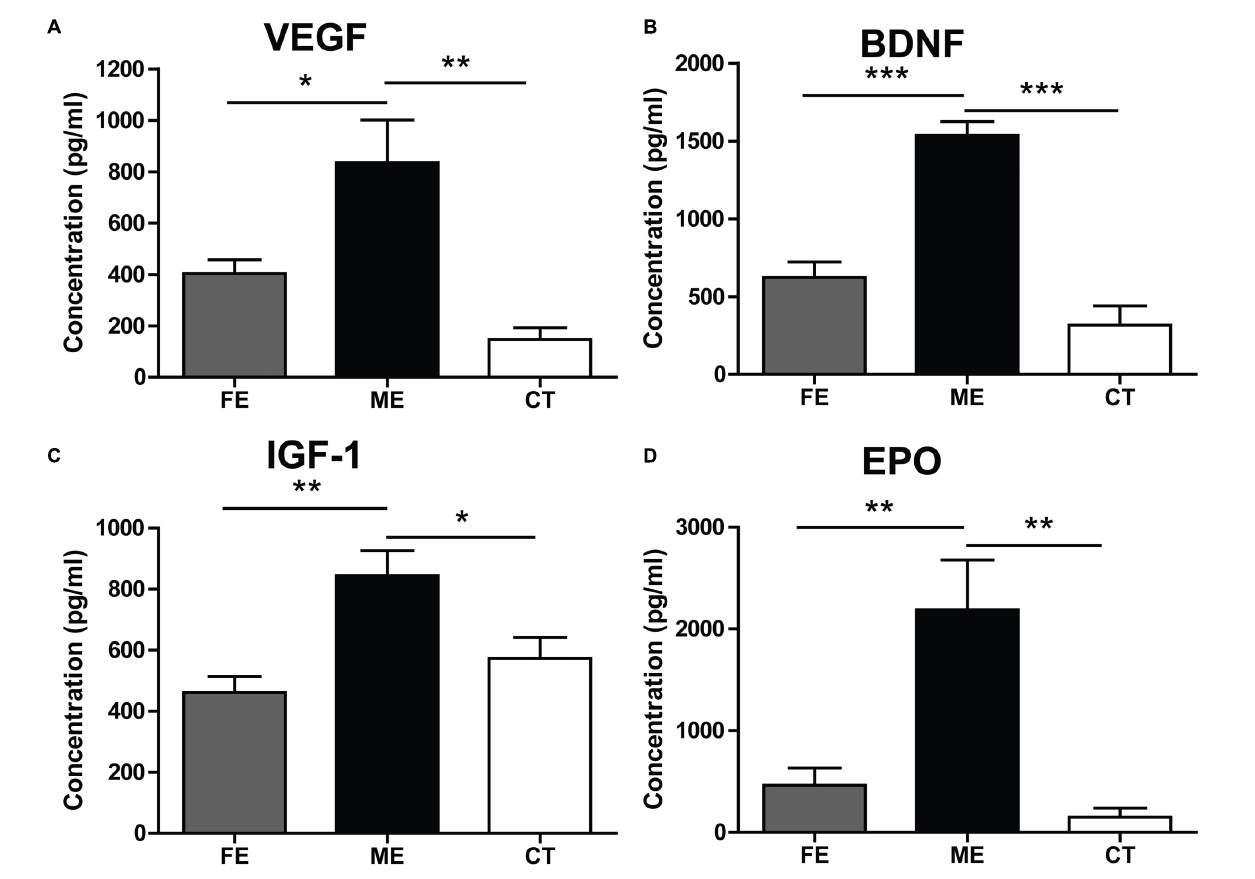
FIGURE 5 | Effects of running on expression of neurotrophic factors vary with intensity. (A) Values of hippocampal VEGF levels. One-way ANOVA, F 2 , 12 = 11.12, P = 0.0019; post hoc test: ME vs. CT: ∗∗ P < 0.01; ME vs. FE: ∗ P < 0.05; FE vs. CT: P > 0.05; n = 5 in each group. (B) Values of hippocampal brain-derived neurotrophic factor (BDNF) levels. One-way ANOVA, F 2 , 12 = 36.43, P < 0.0001; post hoc test: ME vs. CT: ∗∗∗ P < 0.001; ME vs. FE: ∗∗∗ P < 0.001; FE vs. CT: P > 0.05; n = 5 in each group. (C) Values of IGF-1 levels in the brain. One-way ANOVA, F 2 , 12 = 8.315, P = 0.0037; post hoc test: ME vs. CT: ∗ P < 0.05; ME vs. FE: ∗∗ P < 0.01; FE vs. CT: P > 0.05; n = 5 in each group. (D) Values of hippocampal EPO levels. One-way ANOVA, F 2 , 12 = 13.14, P < 0.0009; post